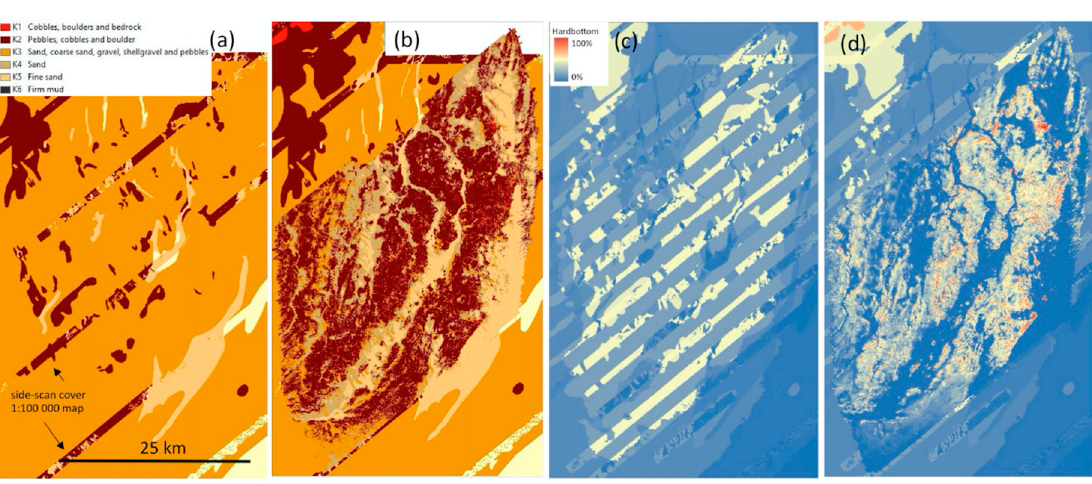
Figure 12. Before and after comparison between existing thematic map products of surface substrate and the new continuous models overlaid. ( a ) SGU legacy surface substrate maps (combination of 1:500 000 and 1:100 000 map), ( b ) same as ( a ) with the reclassified substrate models map overlaid, ( c ) percent hard bottom map developed by SGU from the legacy thematic maps (same as a) for the marine spatial planning cumulative impact assessment tool Symphony [10], ( d ) same as ( c ) with the new percent hard bottom model overlaid.